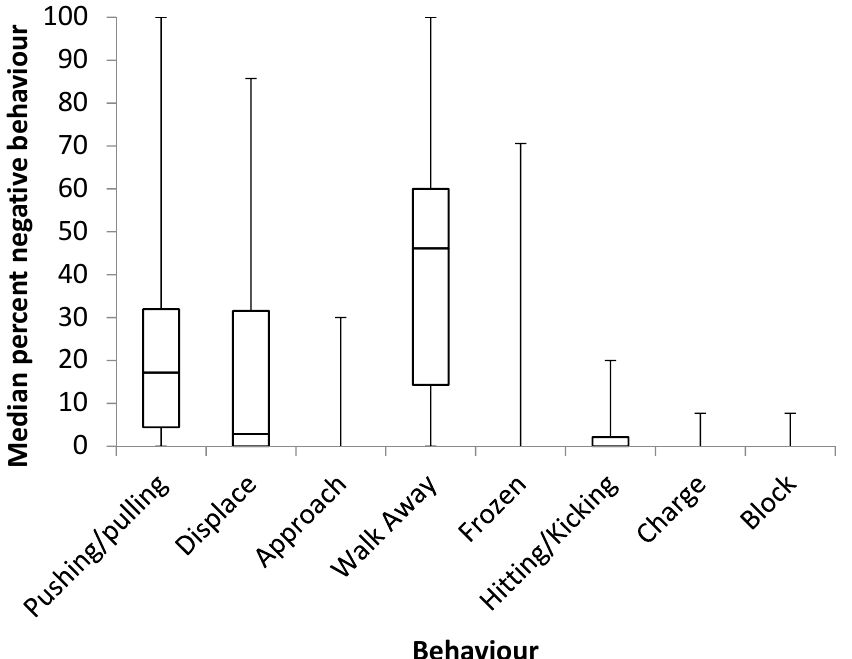
Figure 2. A breakdown of negative interactions observed. Pushing/pulling and hitting/kicking were grouped as physical interactions.